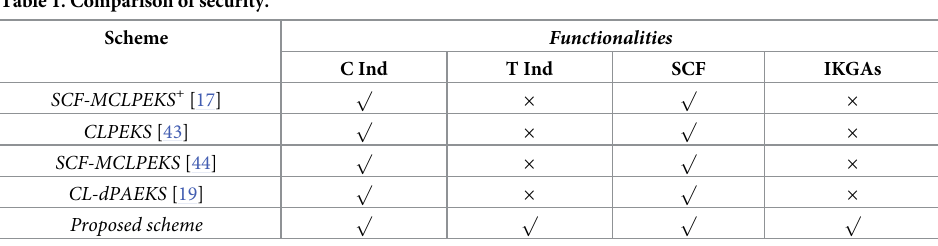
Table 1. Comparison of security. Scheme